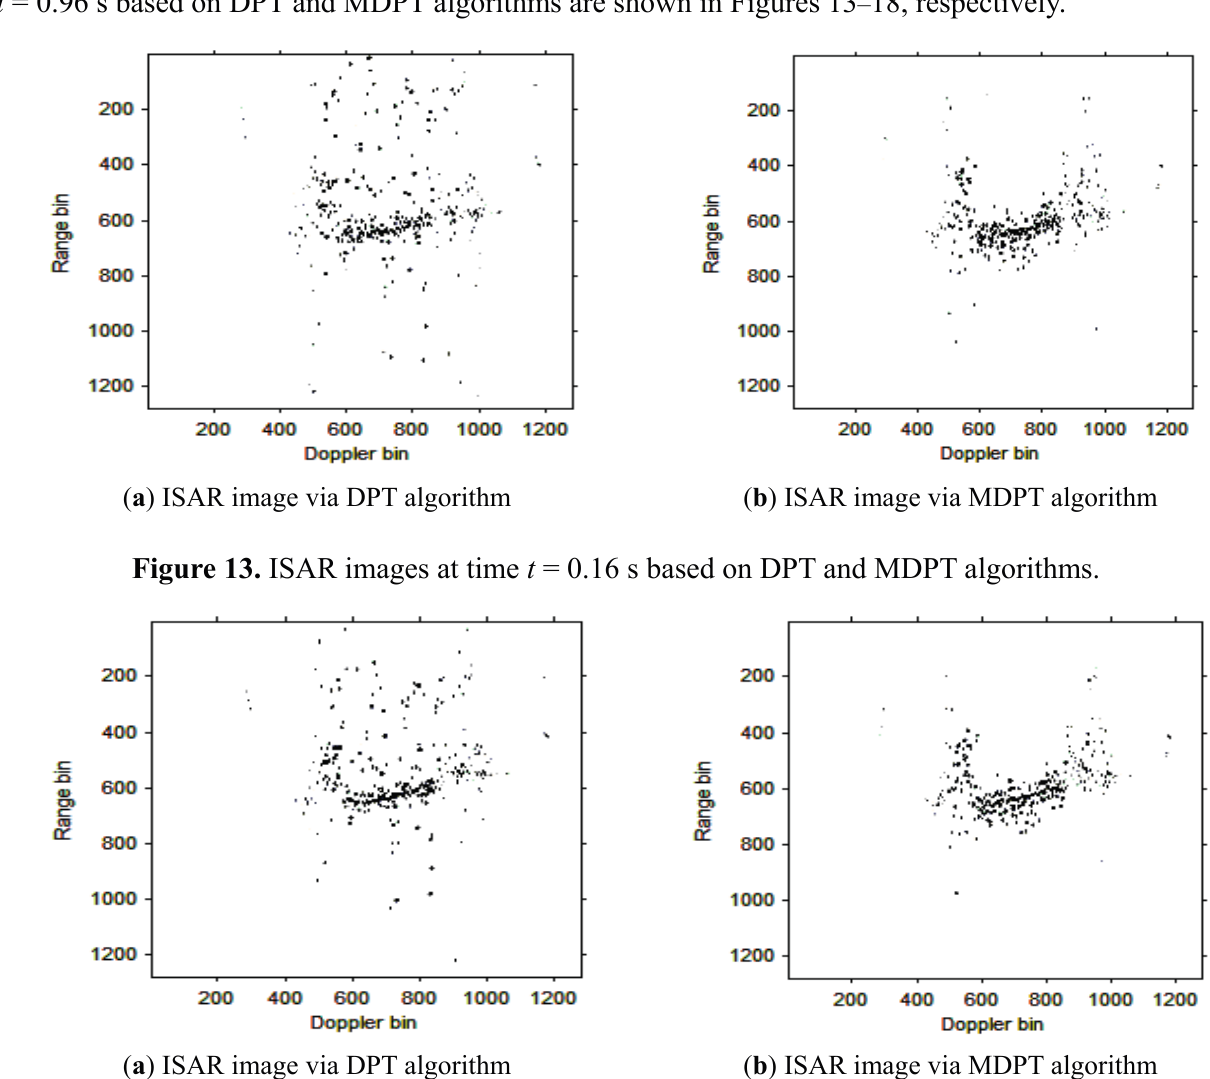
Figure 14. ISAR images at time t = 0.32 s based on DPT and MDPT